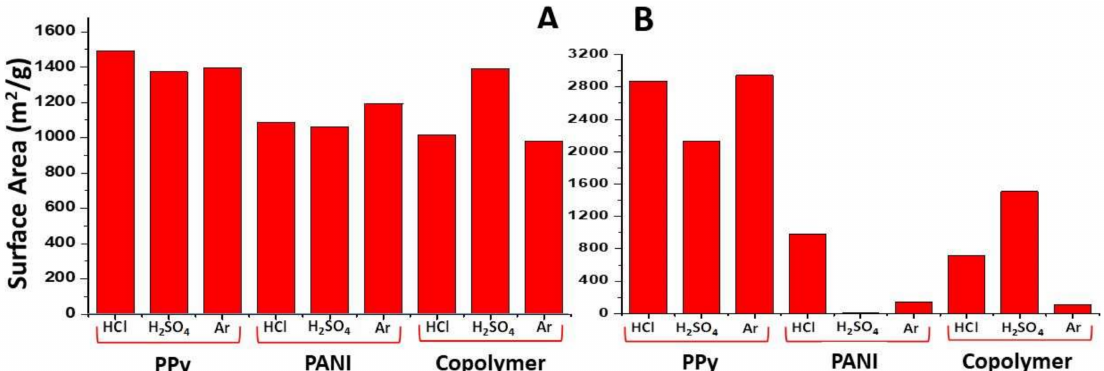
Figure 2. Graphical illustration of surface area of the activated carbon obtained from pyrolysis of various polymers: ( A ) amount of N-GOs obtained when carbonization and activation were carried using polymer: KOH at a ratio of 1:2; ( B ) amount of N-GOs obtained when carbonization and activation were carried using polymer: KOH at a ratio of